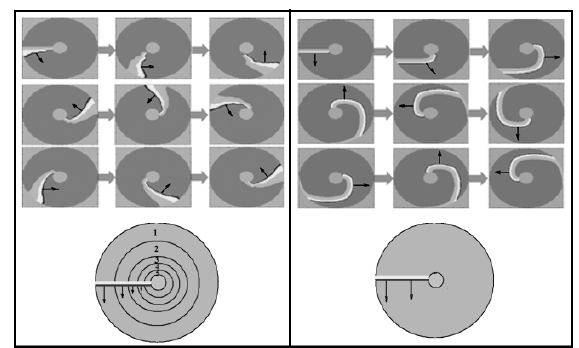
Fig. 3. Initial data for the formation of a concave autowave (left) in the Fitzhugh – Nagumo model. The velocity of the autowave propagation in the selected bands decreases from the periphery to the center due to an increase in the diffusion coefficient. The direction of wave propagation is shown by arrows. The initial data for the formation of a conventional spiral autowave (right) in the Fitzhugh – Nagumo model, the wave propagation region is uniform, the velocity of the autowave propagation at each point is the same.